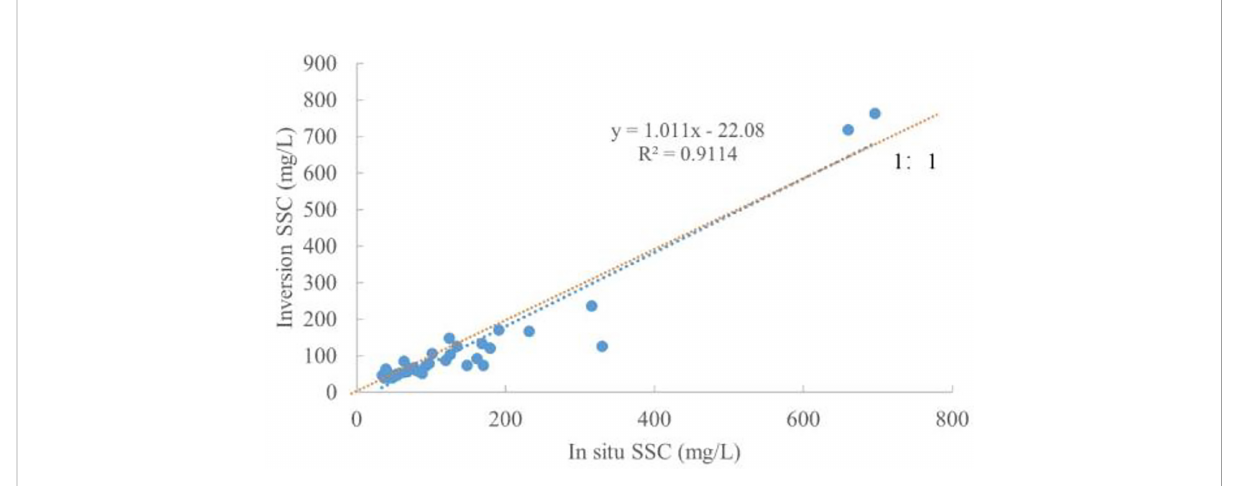
FIGURE 5 Scatter validation of estimated SSC based on GOCI data with in situ concentration.